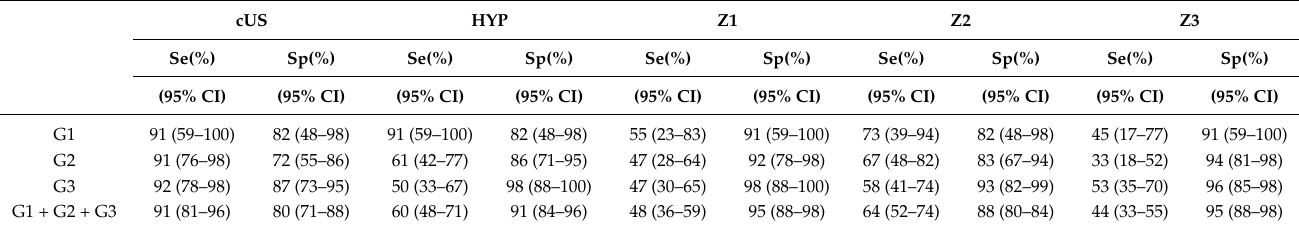
In all the animals enrolled, the highest values of Se (91%) were observed when the complete US was employed (Tables 3 and 4), whereas PPV and NPV values resulted in 80% and 91%, respectively. The cUS confirmed high values of Se and Sp also when the different groups were considered (G1: 91%, 82%; G2: 91%, 72%; G3: 92%, 87%). High values of Se (91%) and Sp (82%) were also observed with HYP scan in G1. When paired, the contiguous zones showed an improved value in Se and Sp, especially in G1 for all the scans (HYP + Z1: 91%, 82%; Z1 + Z2: 91%, 82%; Z2 + Z3: 91%, 82%) and in G3 for Z2 + Z3 (81%, 91%) (Table 4). Table 3. Values of sensitivity and specificity of ultrasonography (US) in the different groups.